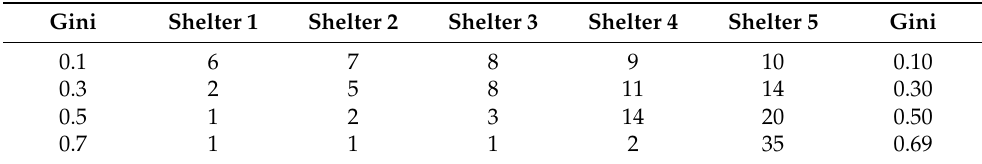
Table A2. Inputs for the simulation when the total demand is 40.